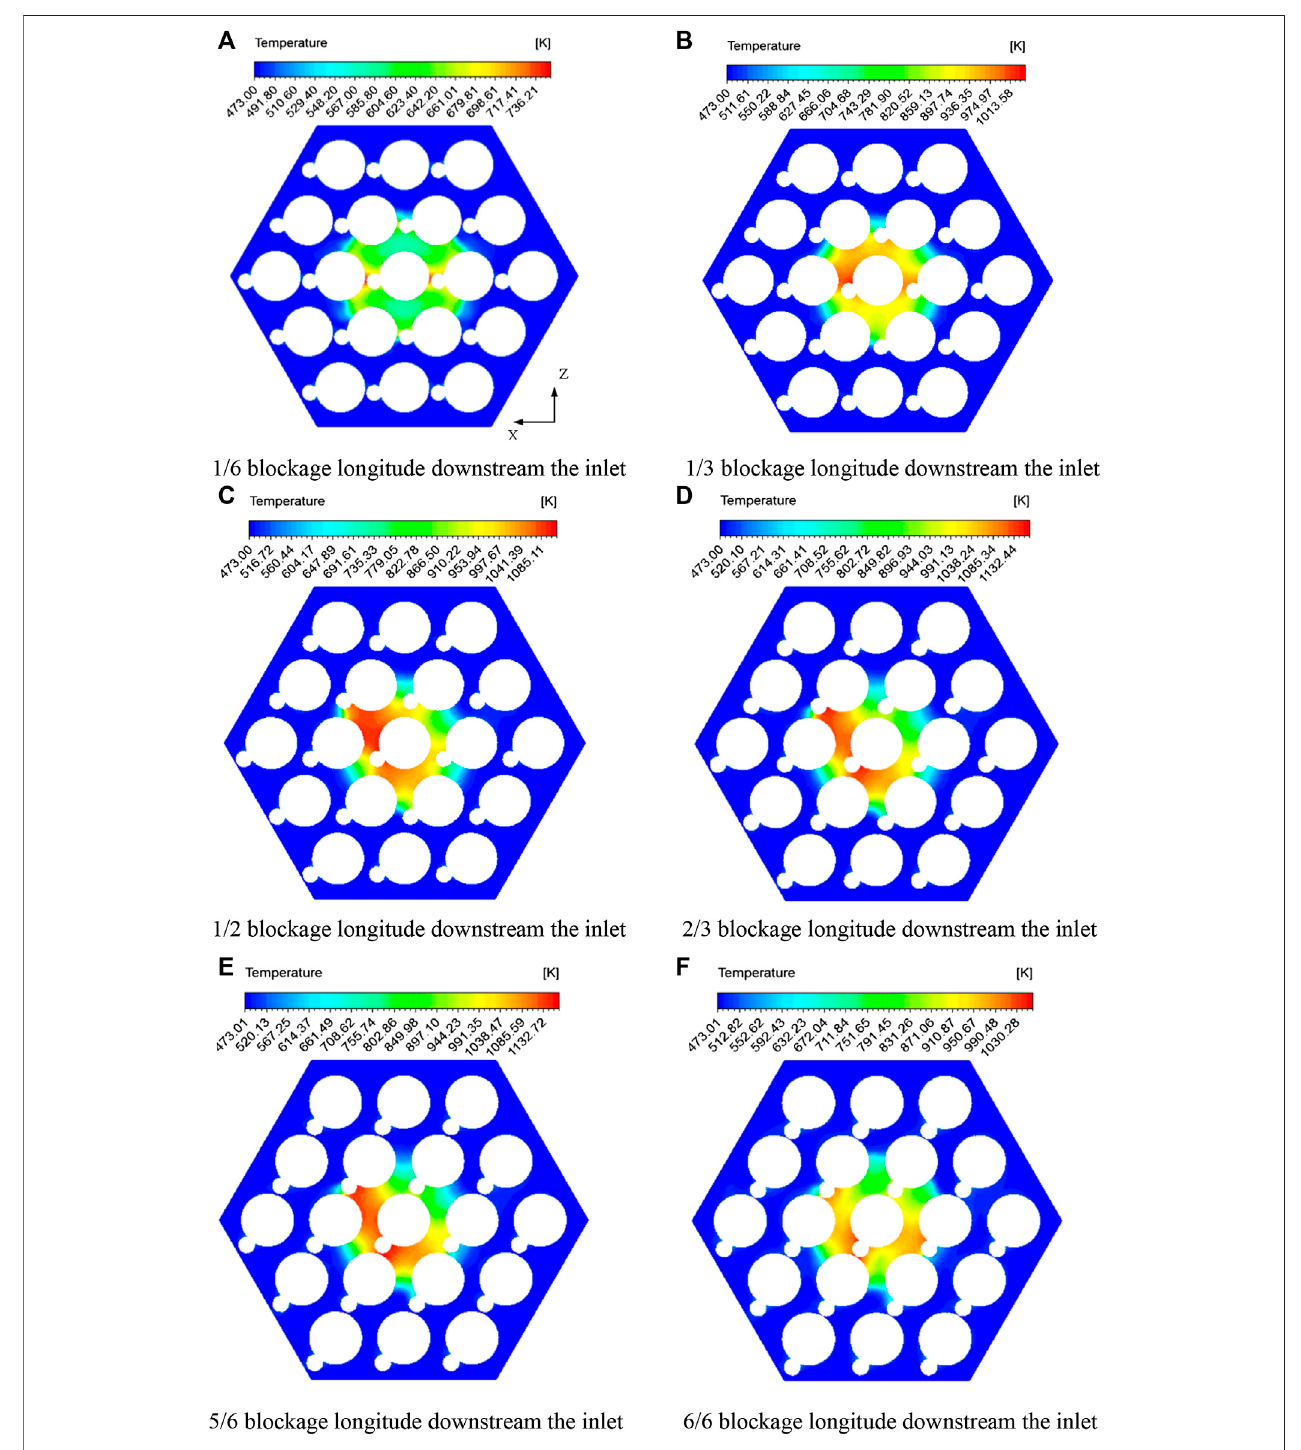
FIGURE 6 | The temperature distributions at six sectional planes in the blocked region. (A) 1/6 blockage longitude downstream of the inlet. (B) 1/3 blockage longitude downstream of the inlet. (C) 1/2 blockage longitude downstream of the inlet. (D) 2/3 blockage longitude downstream of the inlet. (E) 5/6 blockage longitude downstream of the inlet. (F) 6/6 blockage longitude downstream of the inlet.